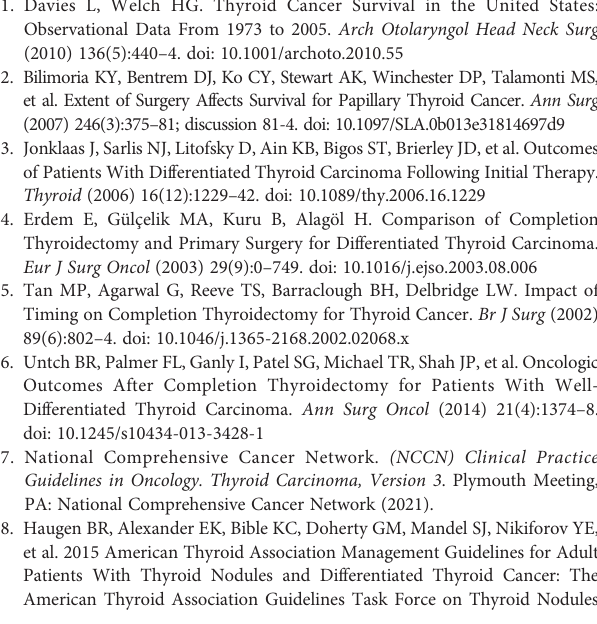
Supplementary Figure S1 | Correlation analysis of age at diagnosis and HVCLNMs rate in patients with papillary thyroid carcinoma. Error bars: 95% con fi dence interval. HVCLNMs, high-volume central lymph node